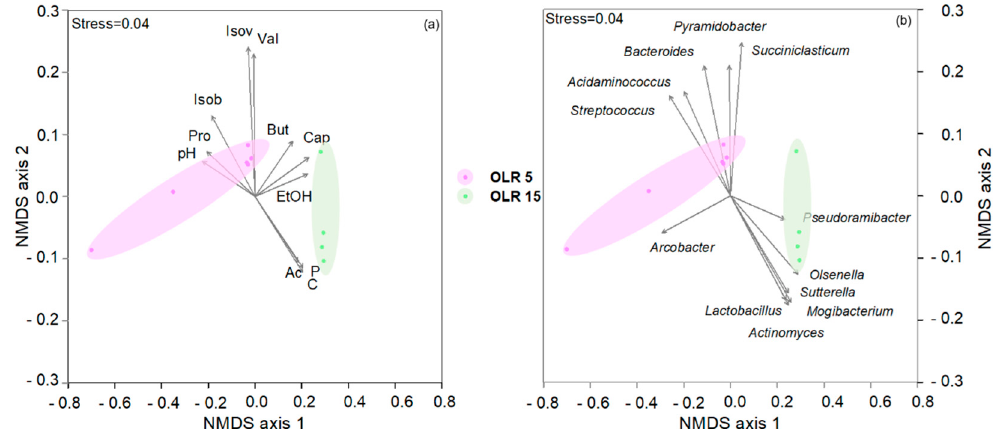
Figure 6. Non-metric MultiDimensional Scaling ordination plot (NMDS) ordination plots, based on Euclidean distance matrixes of log-transformed data. The vector length is proportional to the correlation between the NMDS axes and each process parameter and microbiological values. The stress value (i.e., <0.2) suggests for an accurate representation of the dissimilarity among samples. ( a ) The variation pattern of volatile fatty acids (mg L − 1 ) (Ac, acetate; But, butyrate; Cap, Caproate; Isob, isobutyrate; Isov, isovalerate; Prop, propionate; and Val, valerate); Ethanol (mg L − 1 ), carbohydrates (C) (mgCOD L − 1 ), proteins (mgCOD L − 1 ) (P), and pH. ( b ) The relative abundance of sequencing reads at taxonomical genera level ( ≥ 5% in at least one sample) is projected onto the NMDS ordination synthesising the chemical dissimilarity. Colours indicate the two OLR conditions.